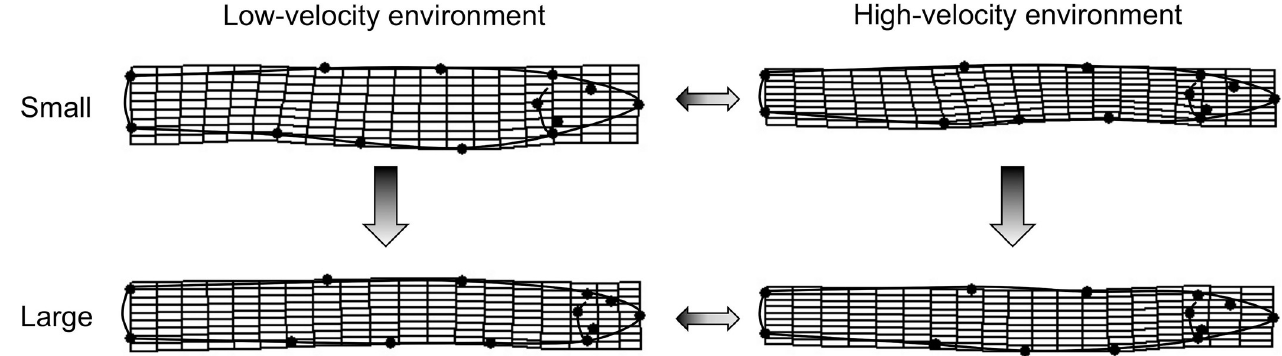
Fig 4. Visualization of variation in body shape. Thin plate spline deformations of divergence in body shape between high-velocity and low-velocity environments for large ontogenetic stage and small ontogenetic stage. Vertical arrows represent the direction of ontogenetic shape change from small to large. Horizontal arrows represent divergence between velocity